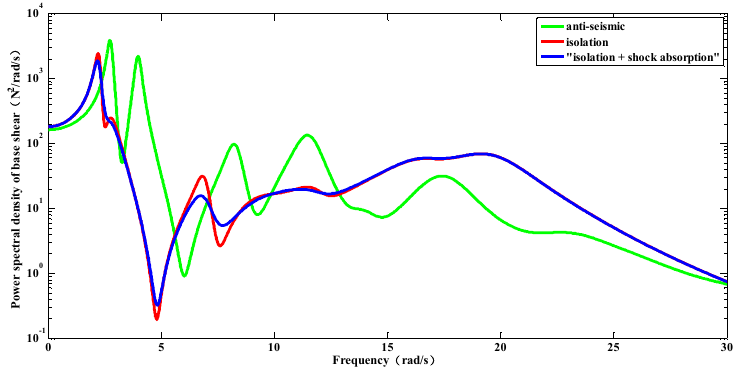
Figure 19. Acceleration power spectral density of structure top layer.